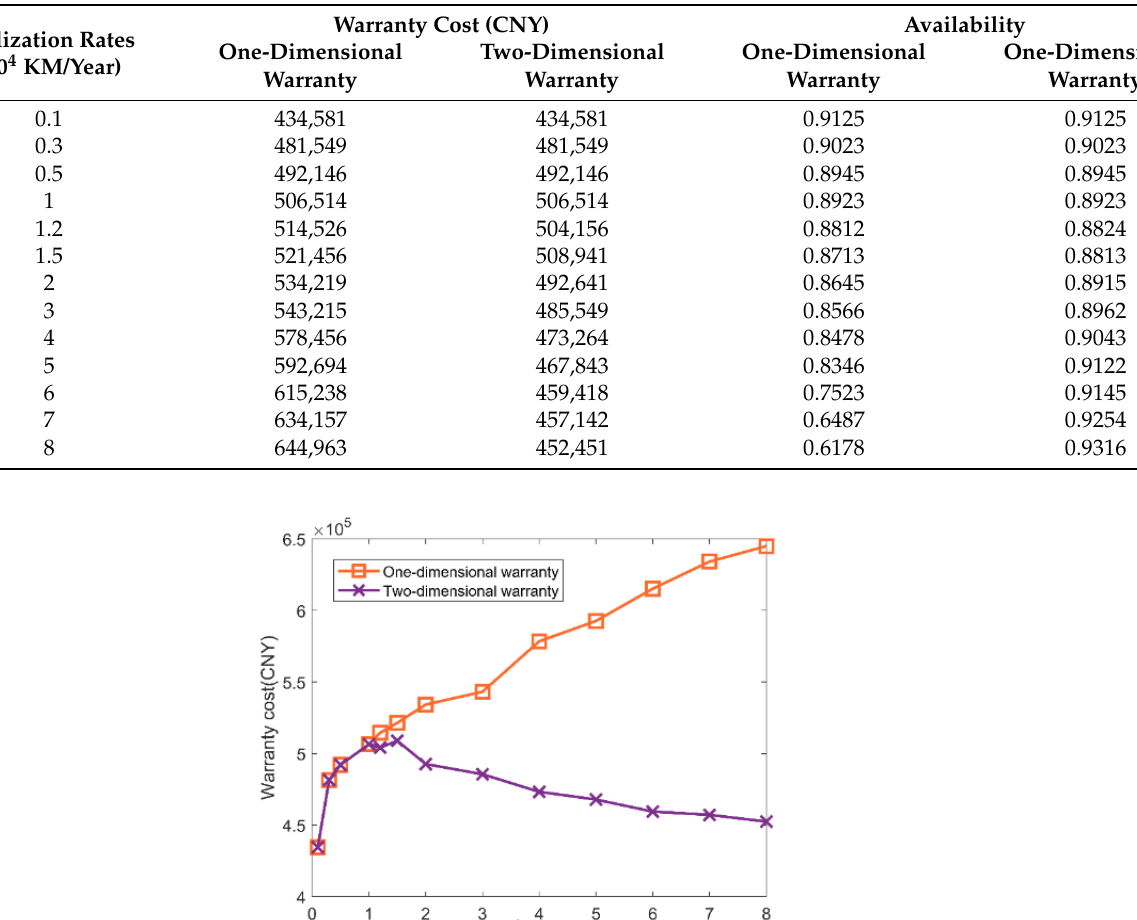
Table 10. Comparison of warranty cost and availability under different warranty methods.